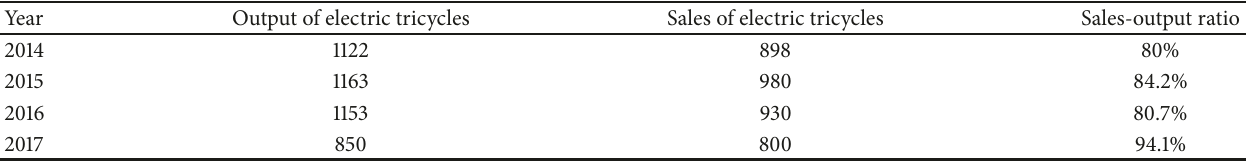
Table 3: Sales-output ratio of electric tricycles in 2014-2017 (unit: 10,000 sets). Output of electric